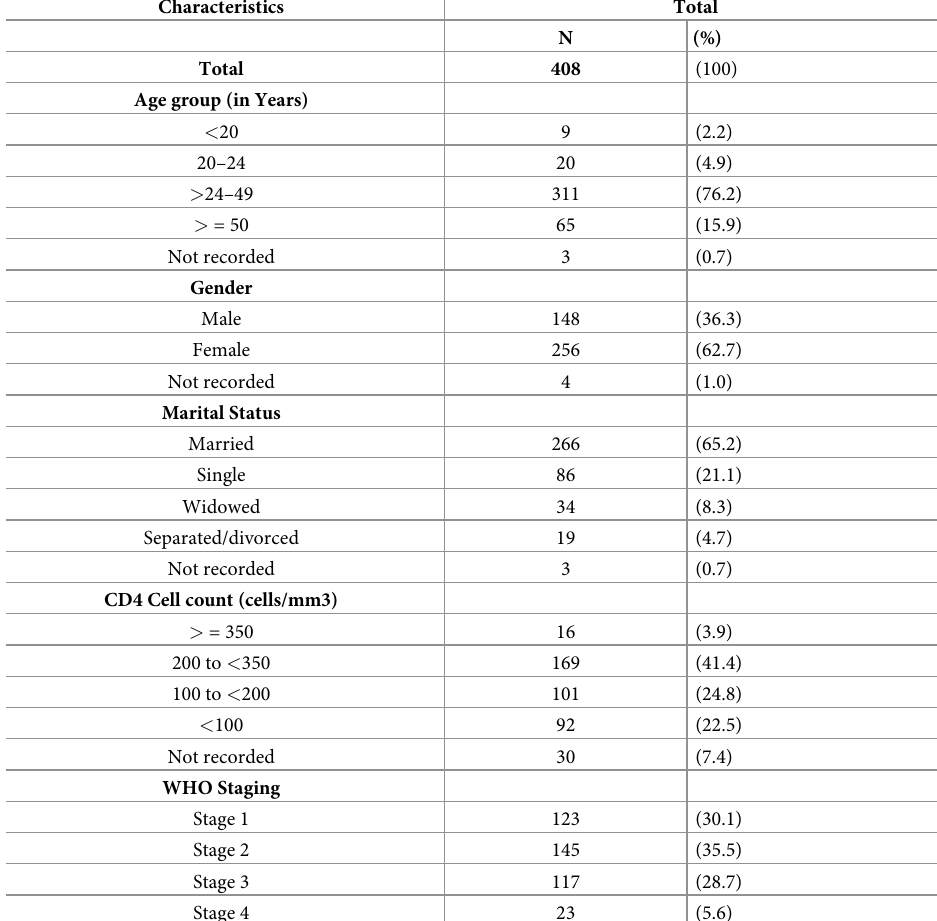
Table 1. Characteristics of PLHIV who were initiated on ART in Bulawayo, Zimbabwe from October 2013 to March 2014 and eligible for IPT.